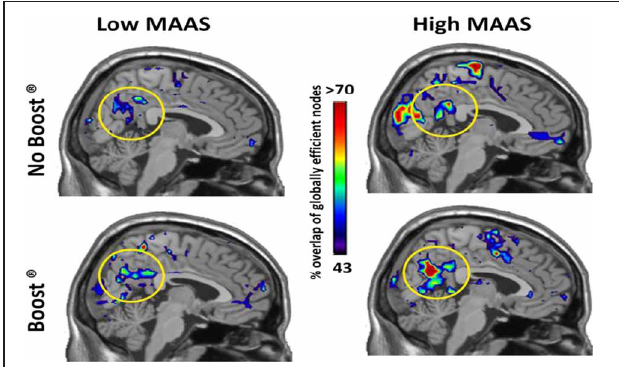
FIGURE 2 | Global Efficiency Maps by MAAS Category: Precuneus. This figure shows a mid-saggital section of the brain for each group and condition. The regions that consistently exhibited high global efficiency across the study populations are color-coded according to % of the population. Note that the precuneus shows highest consistency in the High MAAS group following BOOST ® . The Low MAAS group exhibited low consistency in this area regardless of